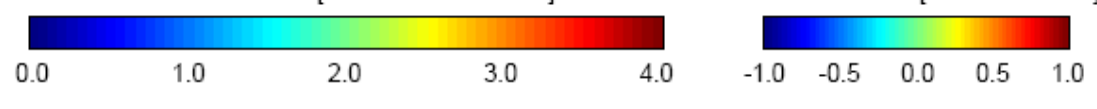
Fig. 2. CO total columns over the Pacific during 5–8 (first row), 14–17 (second row), and 25–28 (third row) of May 2003 observed by MOPITT (first column) and simulated by GEOS-Chem with original biomass burning emissions (second column) and with enlarged biomass burning emissions (third column). Indochina biomass burning emissions in April (not May) are increased by a factor 8 in this simulation. The fourth column shows the difference of column CO in this simulation (third column) from the standard simulation (second column). MOPITT averaging kernel was applied to the model results. The location of the NOAA ESRL monitoring site (GMI) is shown as an open